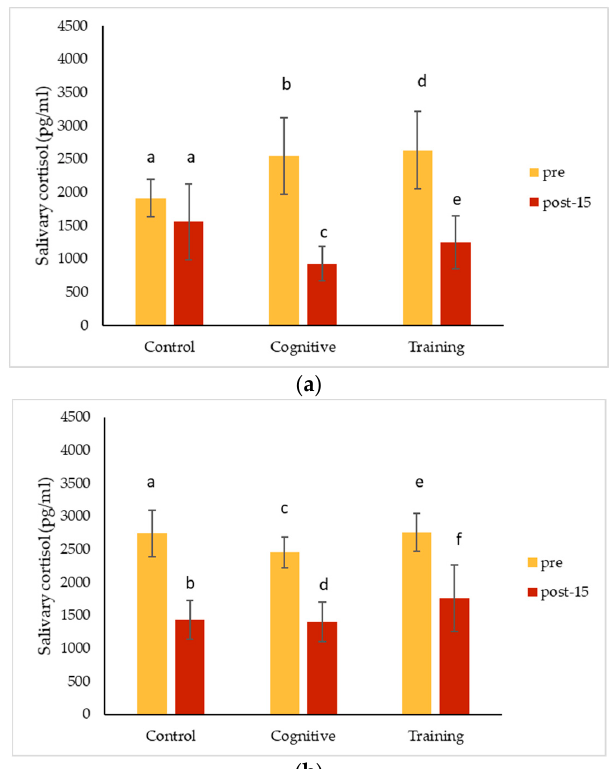
Figure 4. Rates of all-occurrence behaviors (mean ± standard error) including grumble vocalizations (vocalization), mesh depart (departing) and self-directed behavior (SBD) during two types of human– animal interactions and a control condition for ( a ) Chip; ( b ) Pende; and ( c ) Kongo. ** Indicates a significant difference of p < 0.05 and * indicates a trend (0.05 ≤ p < 0.1) between conditions connected by a line based on Wilcoxon signed rank tests with Monte Carlo